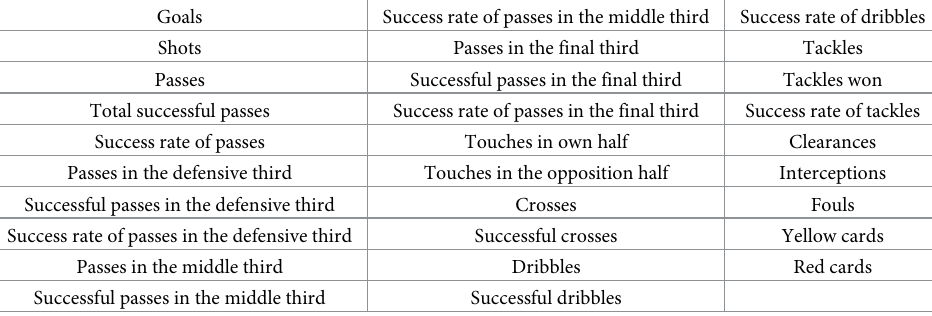
Table 1. Key performance indicators analyzed in FIFA Women’s World Cup 2011 and 2015. Goals Success rate of passes in the middle third Success rate of dribbles Shots Passes in the final third Tackles Passes Successful passes in the final third Tackles won Total successful passes Success rate of passes in the final third Success rate of tackles Success rate of passes Touches in own half Clearances Passes in the defensive third Touches in the opposition half Interceptions Successful passes in the defensive third Crosses Fouls Success rate of passes in the defensive third Successful crosses Yellow cards Dribbles Red cards Successful passes in the middle third Successful